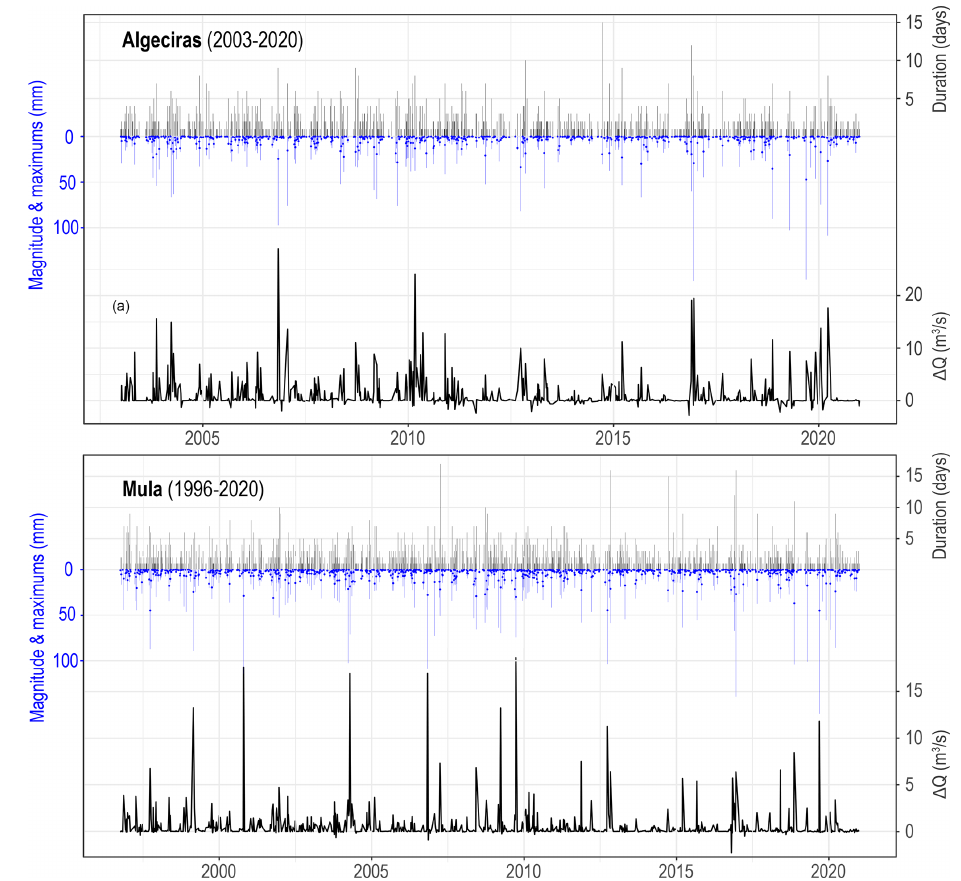
Figure 5. Rainfall events (RE) in Algeciras (upper row) and Mula (lower row) showing the magnitude of the RE (blue bars), the sum of hourly maximums (blue dots), the duration of the RE (narrow black bars over magnitudes), and the flow contributed by the RE (thick continuous black